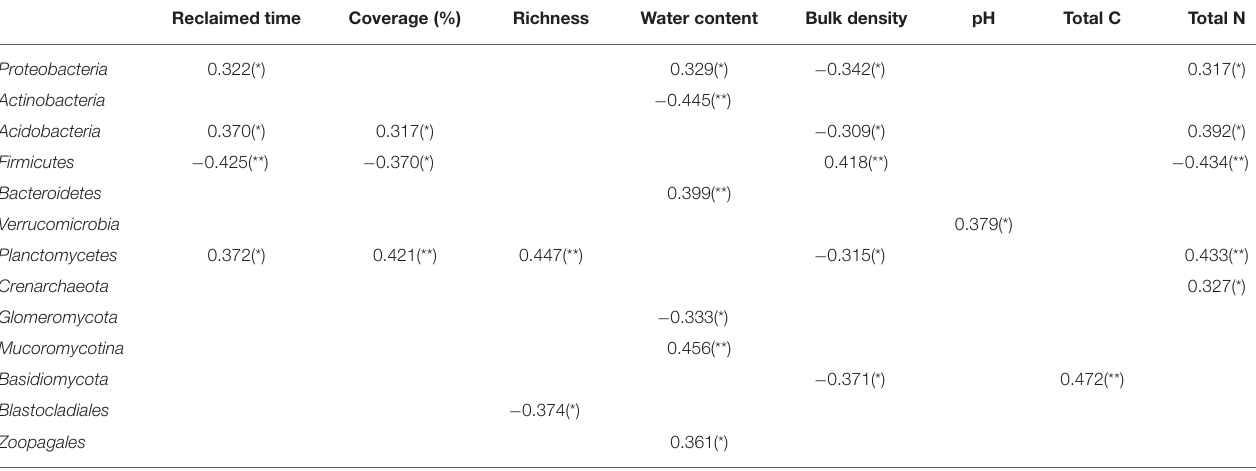
TABLE 4 | The Pearson correlation coefficients for the linear regressions between environmental factors and microbial phylum-level relative abundance.